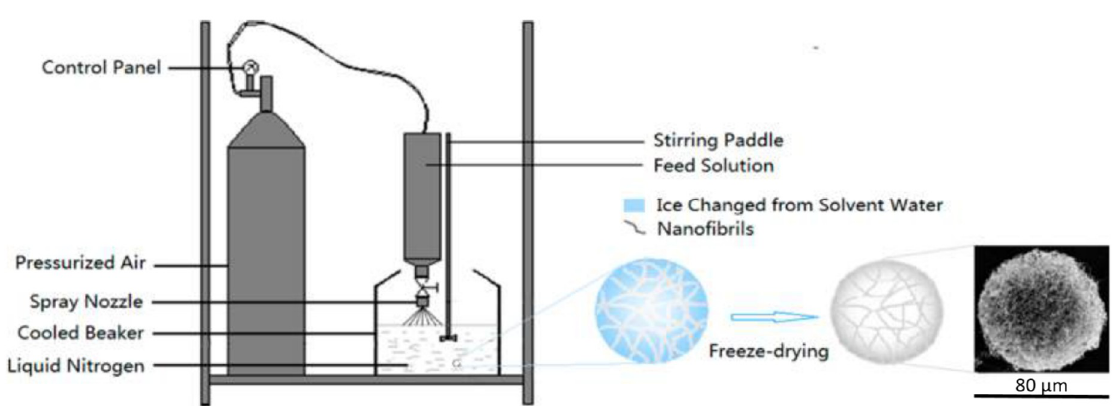
Figure 7. Scheme of the atomisation and spray-freeze-drying process used for the fabrication of porous microspheres. (Adapted with permission from Cai et al. [128]. Copyright 2014 American Chemical Society).